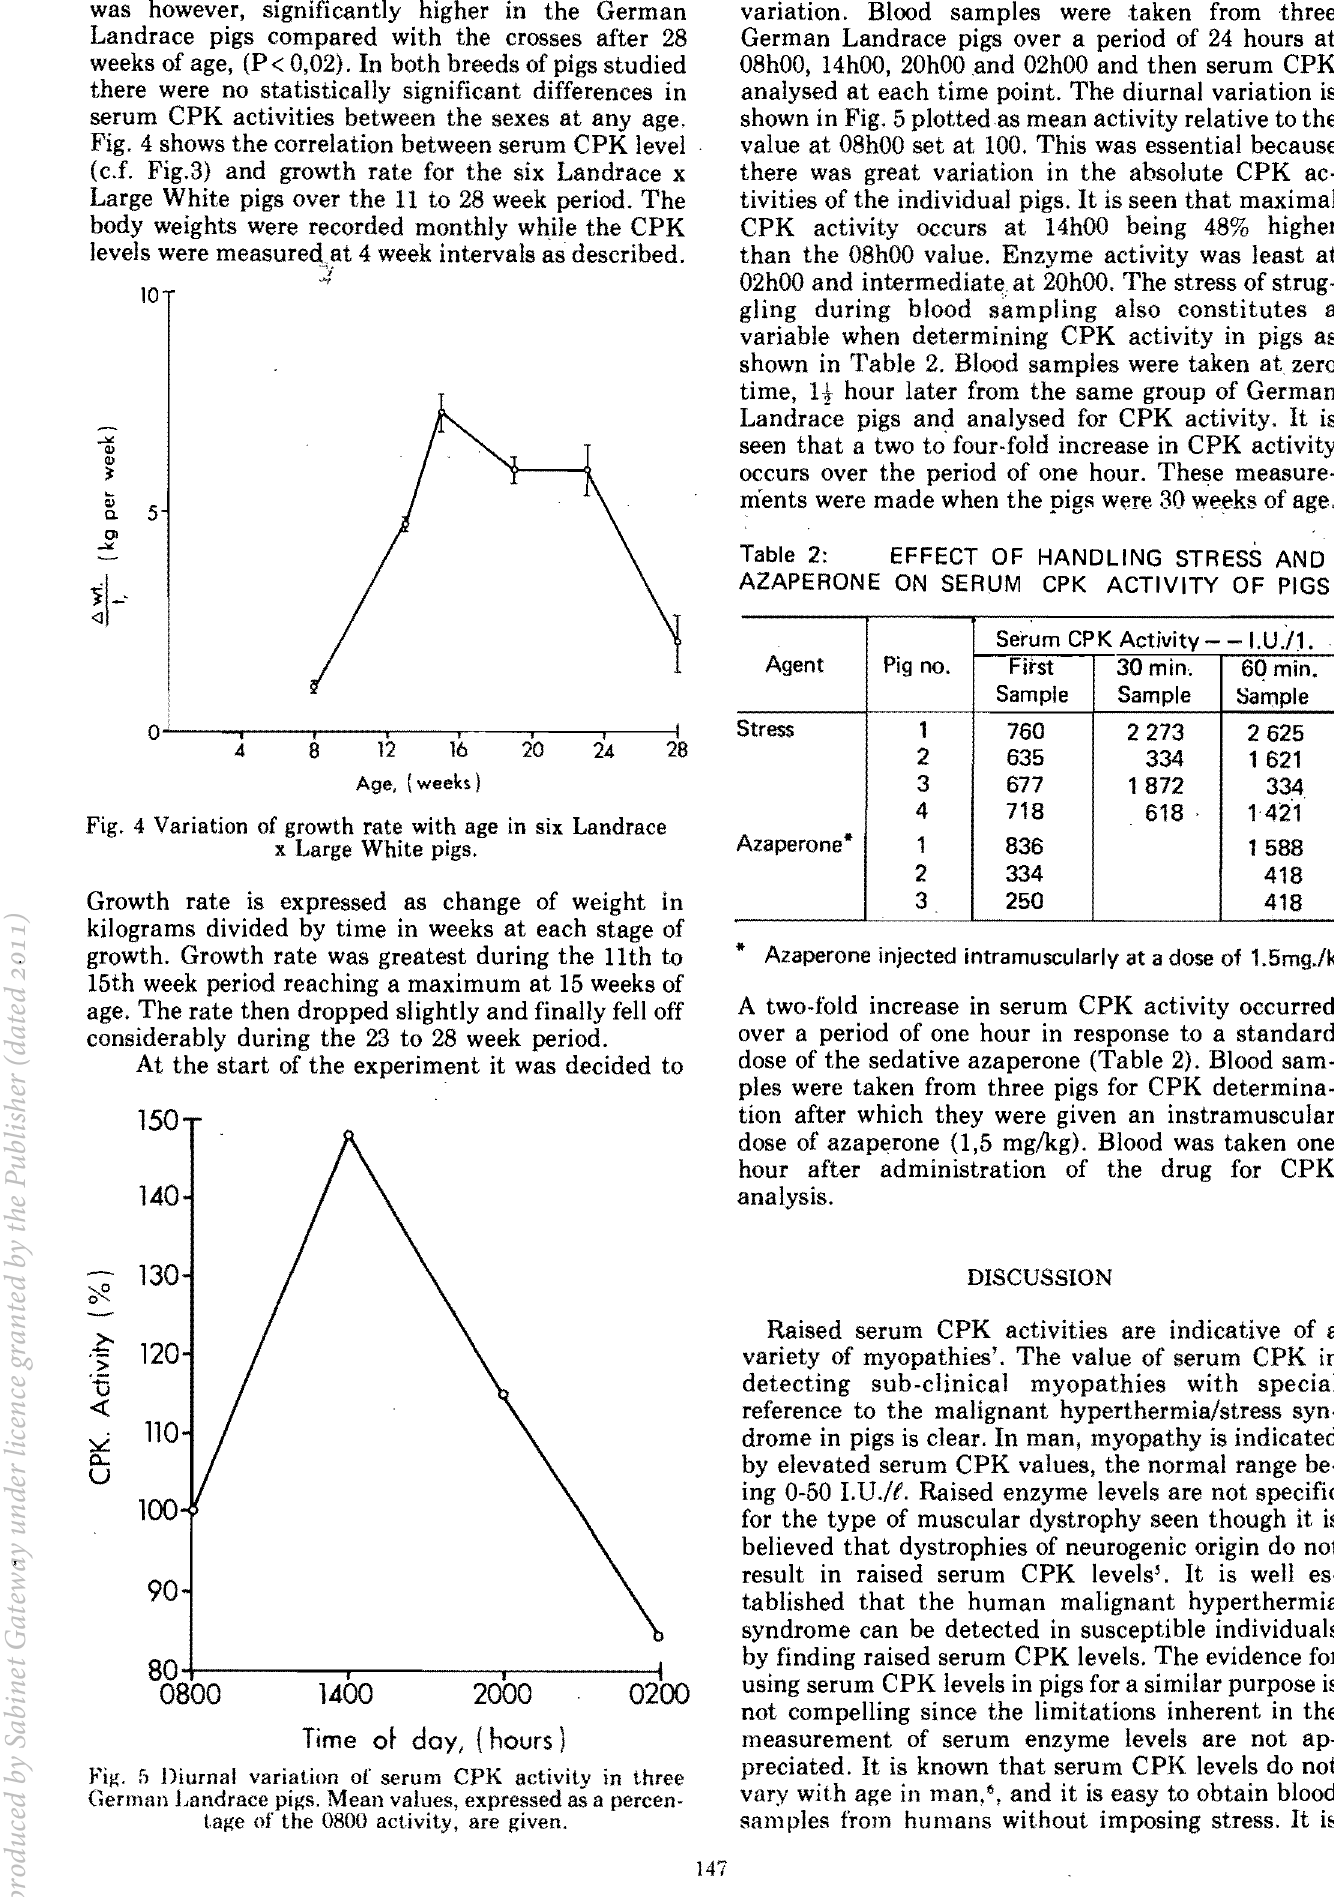
EFFECT OF HANDLING STRESS